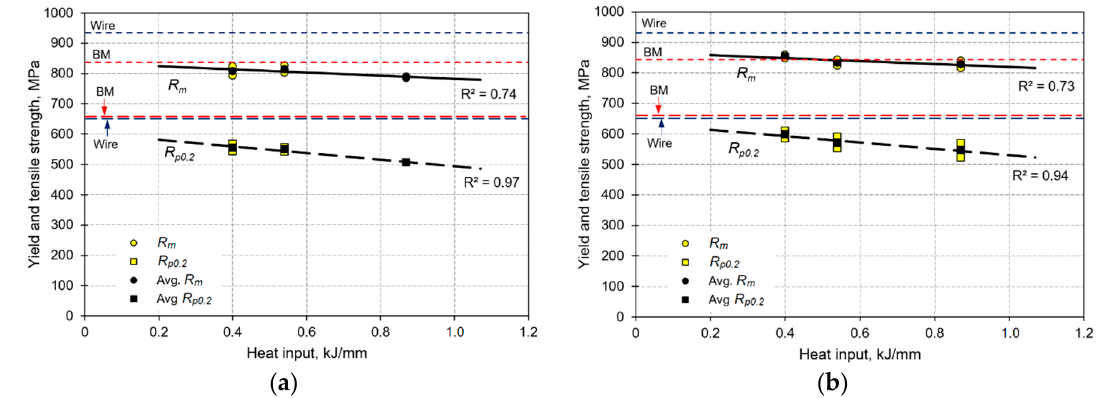
Figure 5. Effect of heat input on yield ( R p0.2 ) and tensile ( R m ) strength for ( a ) vertical samples and ( b ) horizontal samples.